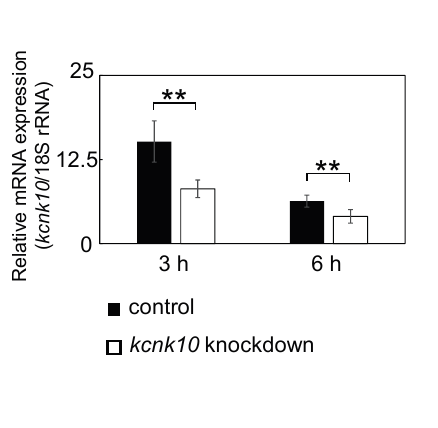
Figure 2. Effect of knockdown of kcnk10 expression on MCE. ( A ) Knockdown of kcnk10 expression by short hairpin RNA (shRNA) expression plasmid at 3 and 6 h after induction. Total RNA obtained from 3T3-L1 cells transfected with a shRNA expression plasmid targeting kcnk10 was subjected to Q-PCR. A scrambled shRNA expression plasmid was used as a control. The level of kcnk10 expression was normalized to the 18S rRNA expression determined by Q-PCR. The data represent means with standard deviations ( n = 3). The asterisks indicate significant differences compared with the values for control cells ( ** p < 0.05); and ( B ) At 72 h after transfection, post-confluent kcnk10 knockdown cells or control cells were induced to differentiate into adipocytes. Cell numbers were determined at various time points using a hemocytometer. The data represent means with standard deviations ( n = 3). The asterisks indicate significant differences compared with the values for control cells ( * p <